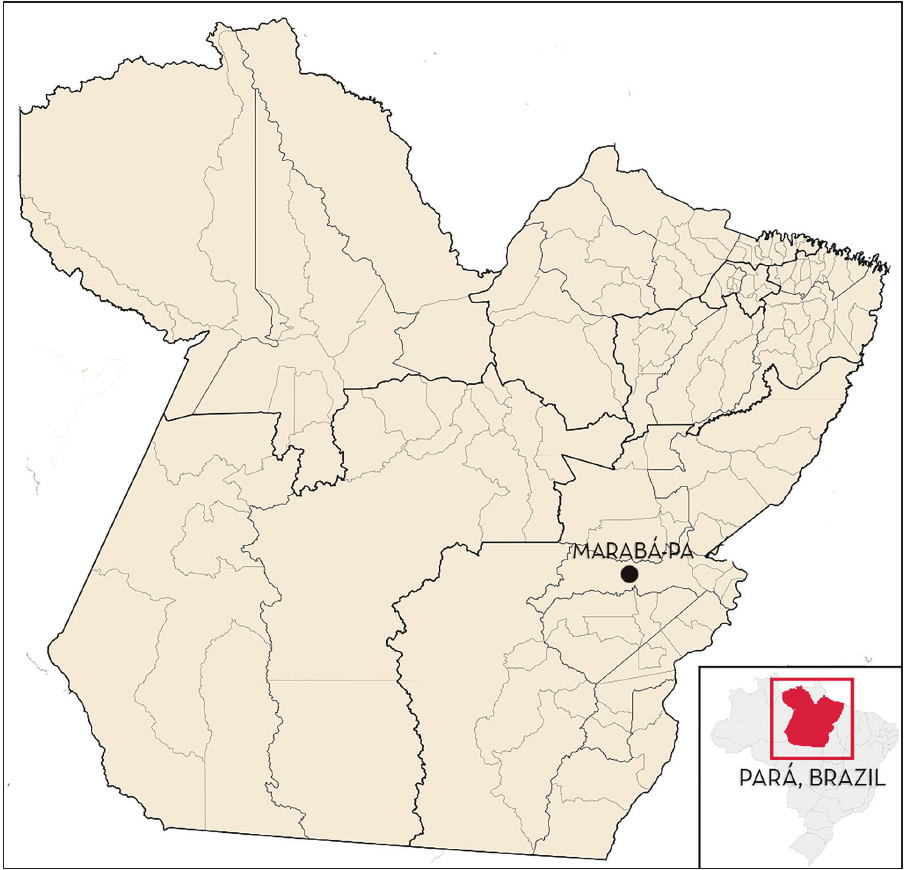
Figure 1. Localization of Marabá- PA where R. marabaensis sp. n. specimens were collected (05°21'54"S,